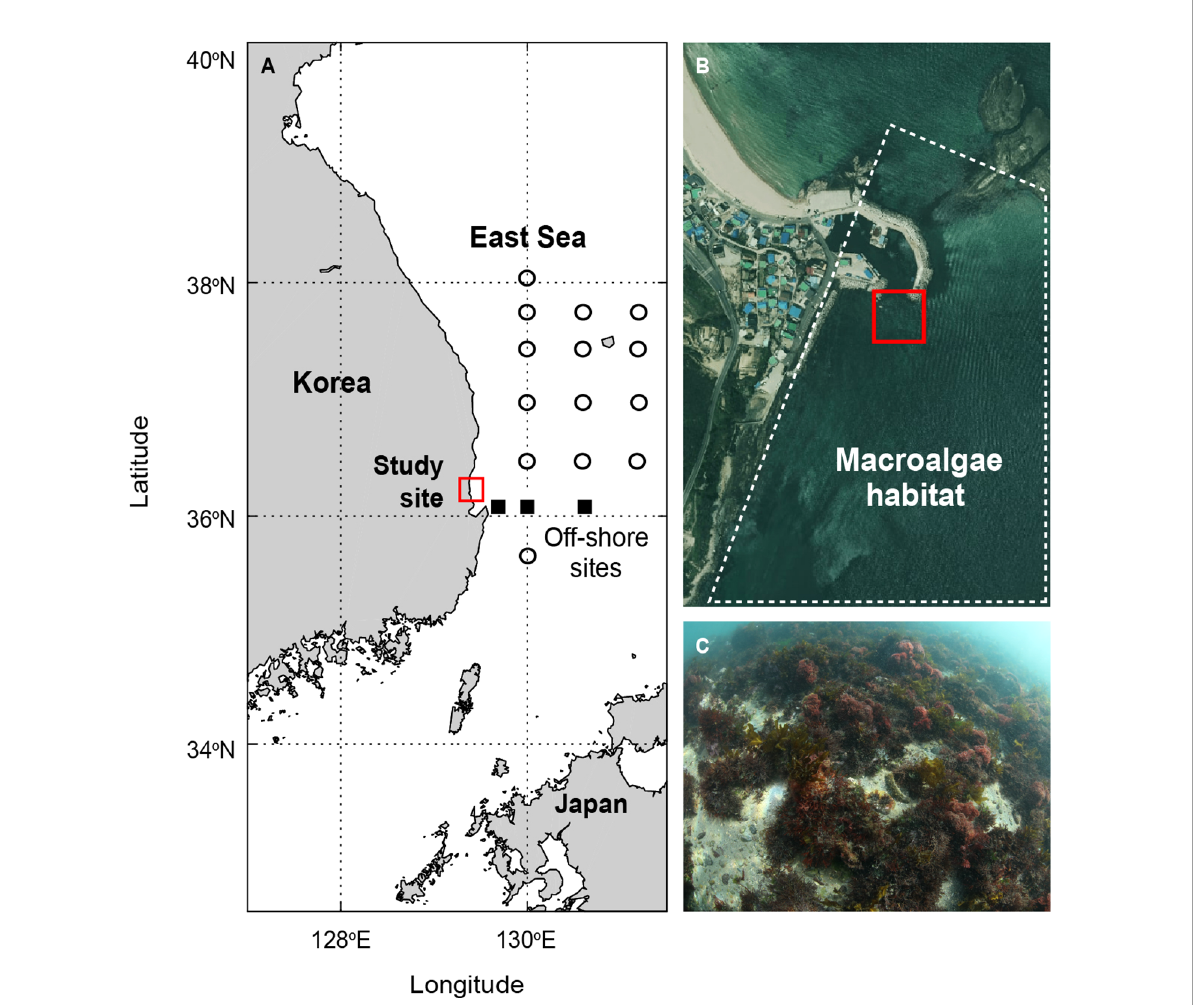
FIGURE 1 (A, B) Sampling site of this study (red box), and (C) dominant macroalgal species in the habitat. The off-shore sites in (A) indicate the location of the sampling site dominated by microalgae for comparison. The seawater carbonate data measured at three sampling stations (squares) in the off-shore sites were used to estimate the effects of off-shore water